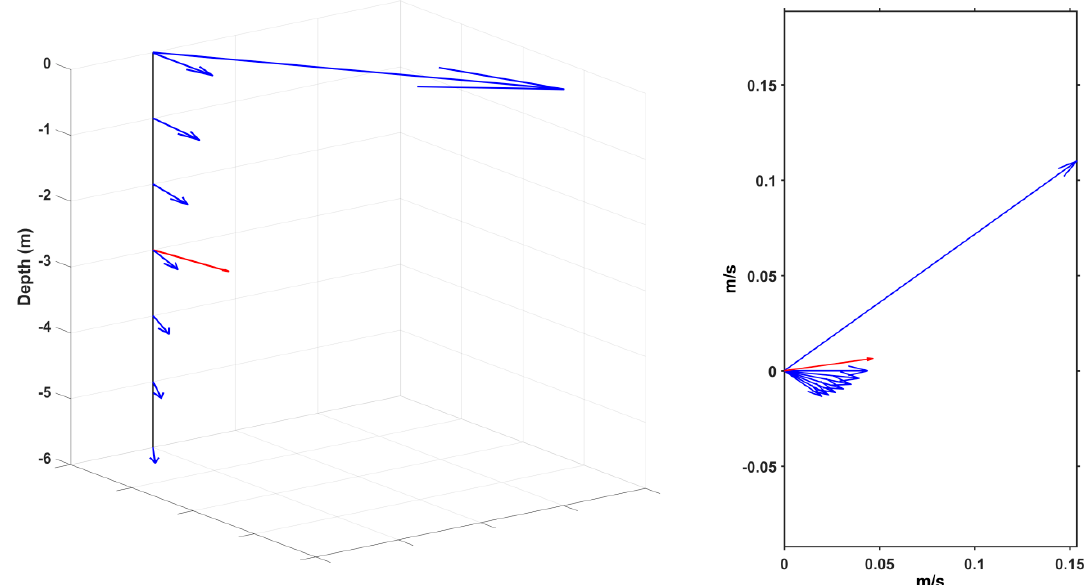
Figure A5. ( Left Panel ) The wind-driven velocity computed from a slip-velocity approach as specified in Csanady [42] (pp. 22–24) (blue arrows) as a function of depth (meters, vertical axis) when forced with a constant wind (u, v) = (5, 5) meters/second. Assuming a 6m deep surface cell, an approximation to the FVCOM’s sea-surface velocity (in red) is computed by averaging the velocity vectors in blue. ( Right Panel ) Hodograph for the ocean current velocity solution (meters/second) that is plotted in the left panel. Results remain qualitatively similar when using other wind speeds that are likewise comparable to the wind speeds observed during the Point Wells 2003